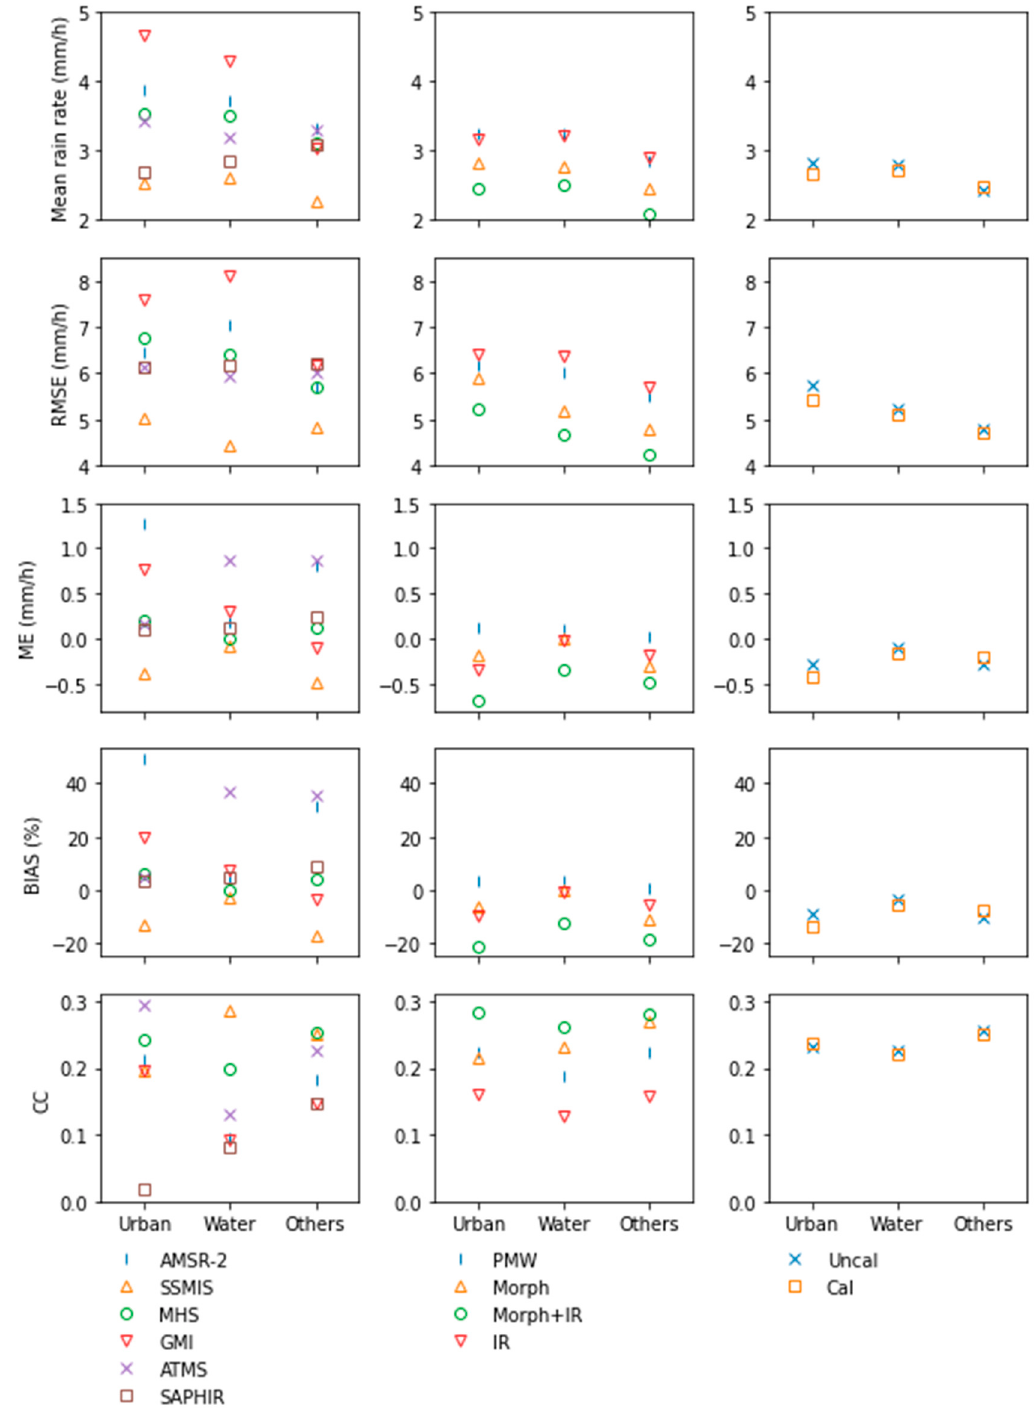
Figure 9. Mean value and four continuous indices, RMSE, ME, BIAS, and CC, of the hit data of 12 IMERG estimates in urban, water, and other areas. The left, middle, and right columns indicate the IMERG estimates for the first, second, and third levels of evaluations.